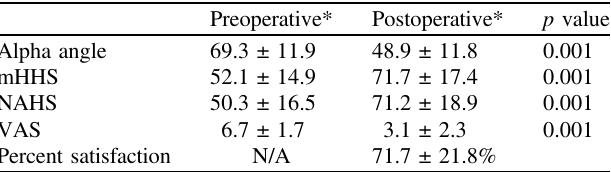
Table 3. Location and extent of Labral tears encountered on an imaginary clock face.